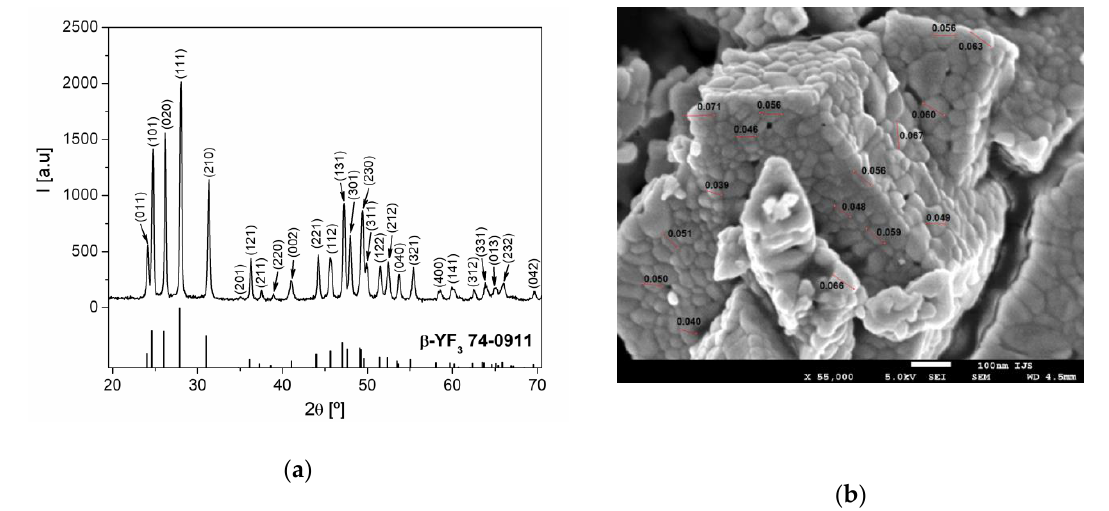
Figure 1. ( a ) The XRD pattern of Y 0.78 Yb 0.2 Er 0.02 F 3 powder. Diffraction peaks are indexed according to PDF Card No. 74-0911; ( b ) SEM image of Y 0.78 Yb 0.2 Er 0.02 F 3 sample.